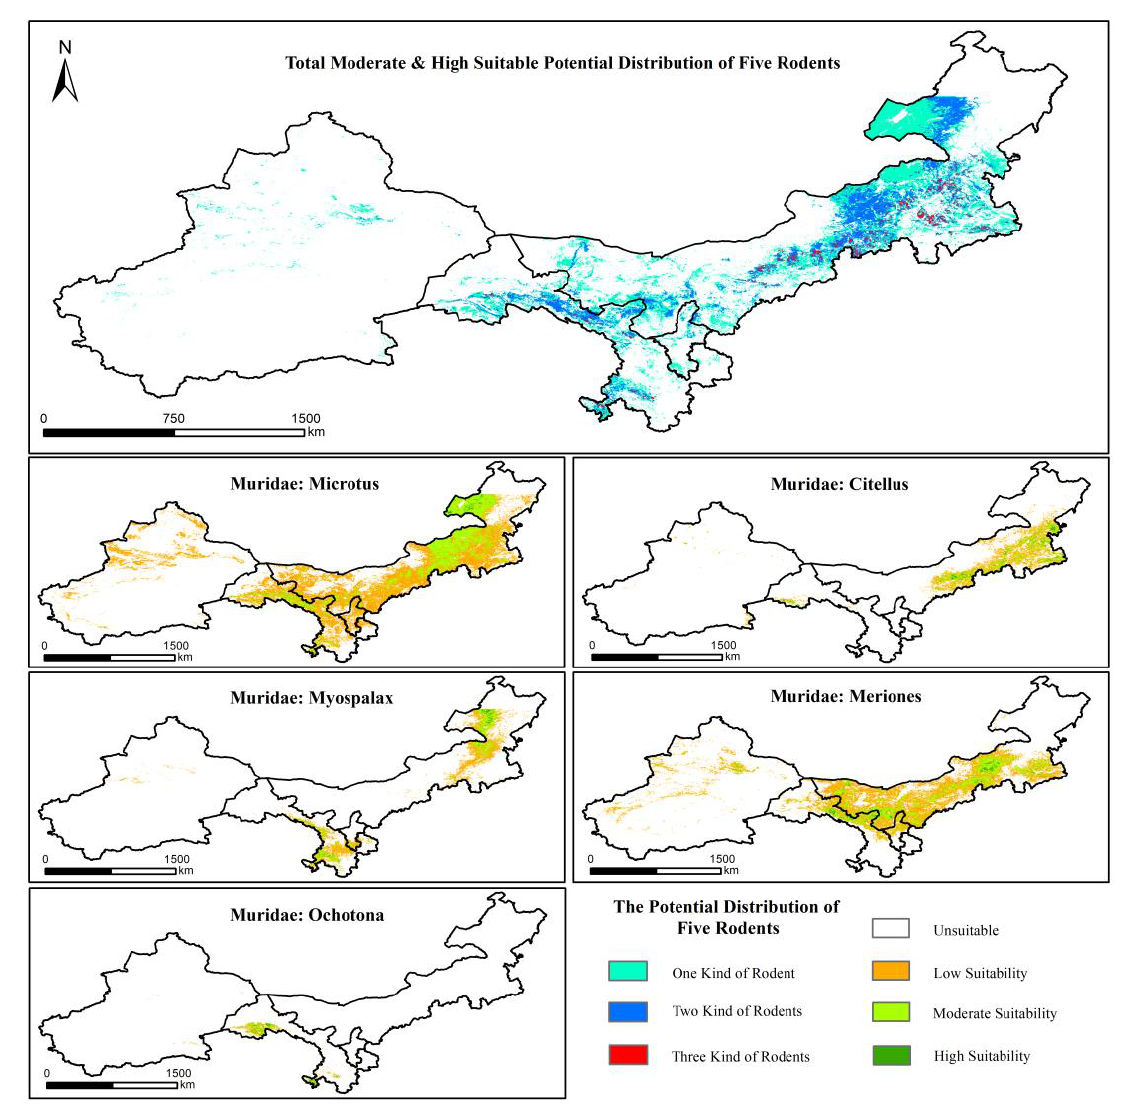
Figure 2. The potential spatial distributions of suitable environmental conditions for five grassland pest rodent species based on the Maxent modeling. Table 2. The proportions of four environmental suitability categories based on Maxent modeling for five rodent species.